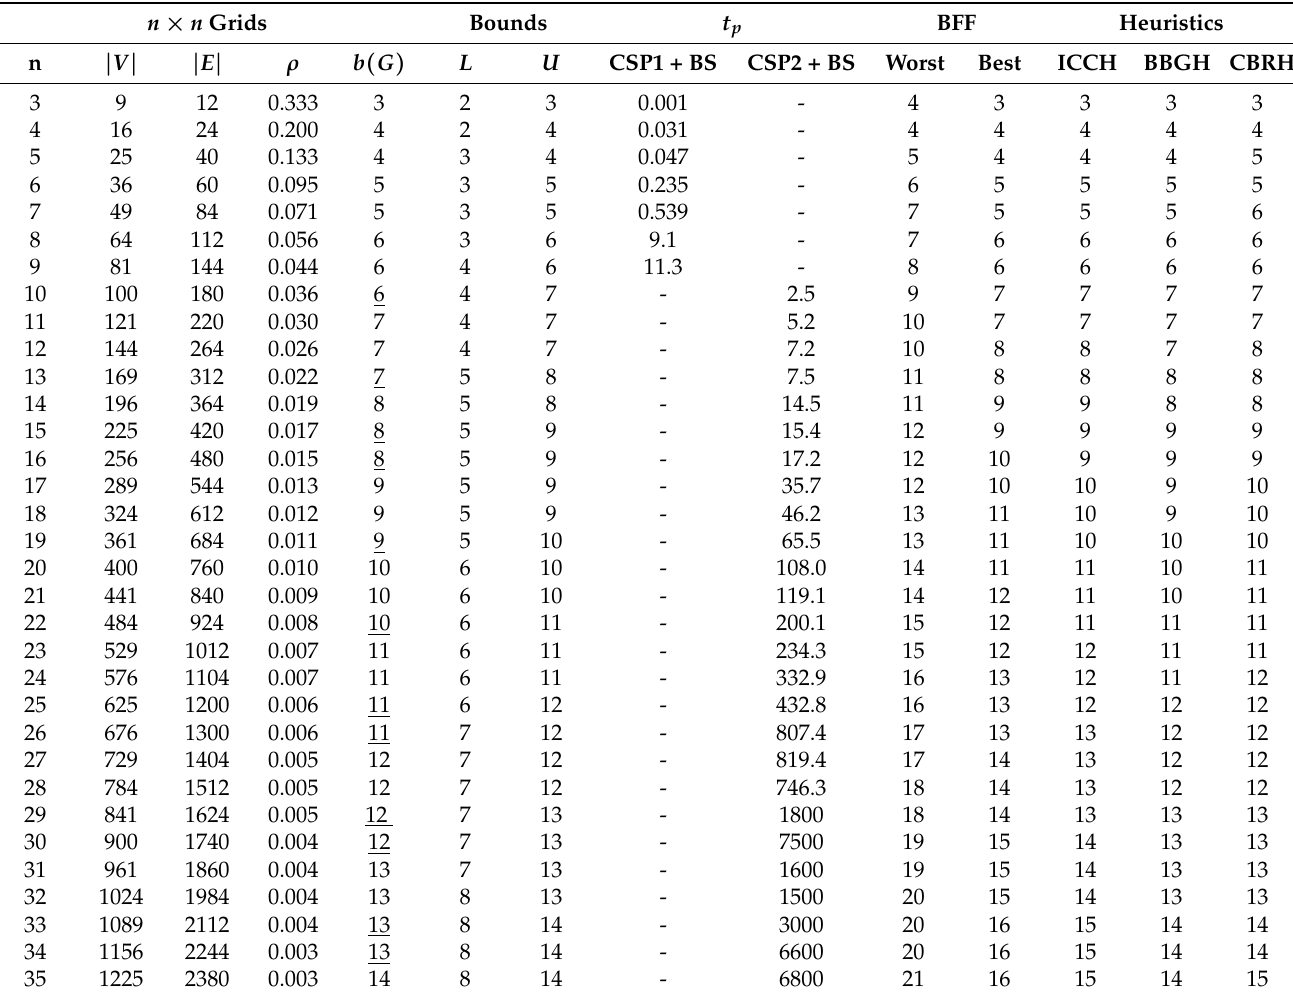
Table 4. Optimal solutions found by CSP1 + BS and CSP2 + BS over some square grid graphs. The feasible solutions found by some state-of-the-art algorithms are reported too. Optimal solutions reported for the first time are